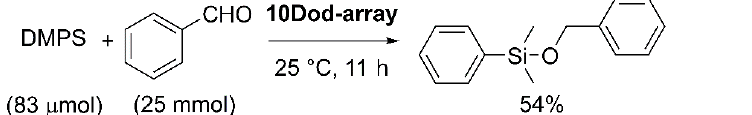
Figure 6. Plausible mechanism of the silane alcoholysis on the AuNP surface accelerated by the charge transfer from support.